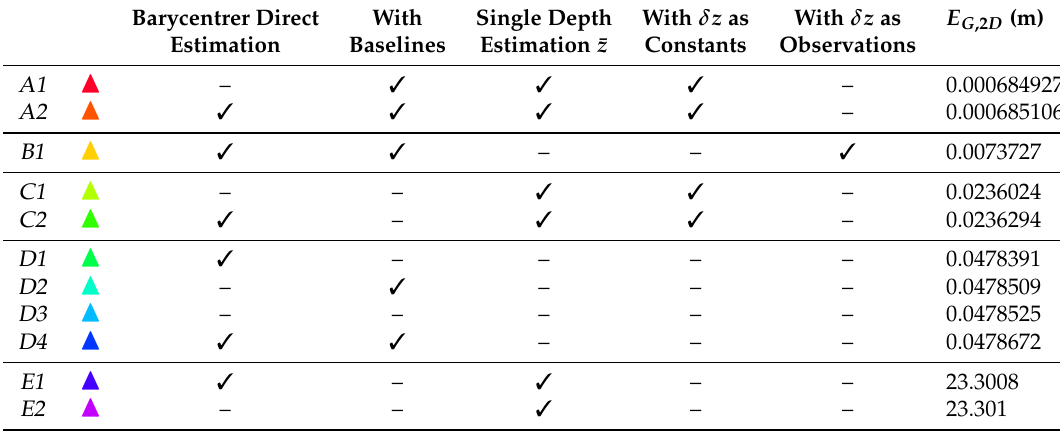
Table 2. Distance to true barycenter for different inversion protocols for a drifting trajectory inscribed in a 100m radius circle.